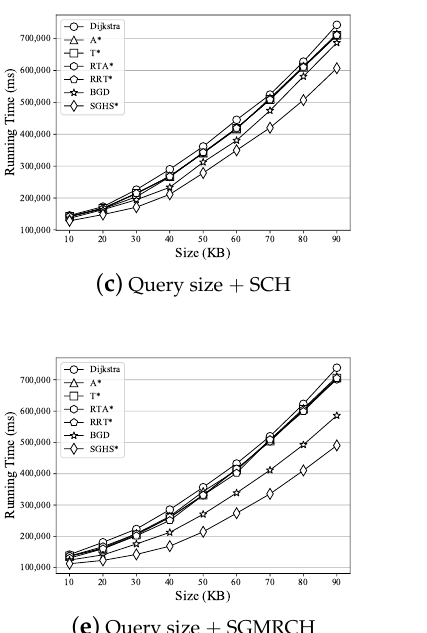
Figure 17. Comparison of running efficiency of algorithms combined with different graph contraction algorithms based on different query